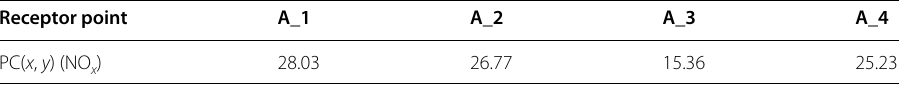
Table 7 Annual pollutant concentration of each receptor point (μg/m 3 ) Receptor point A_1 A_2 A_3 A_4 PC( x , y ) (NO x